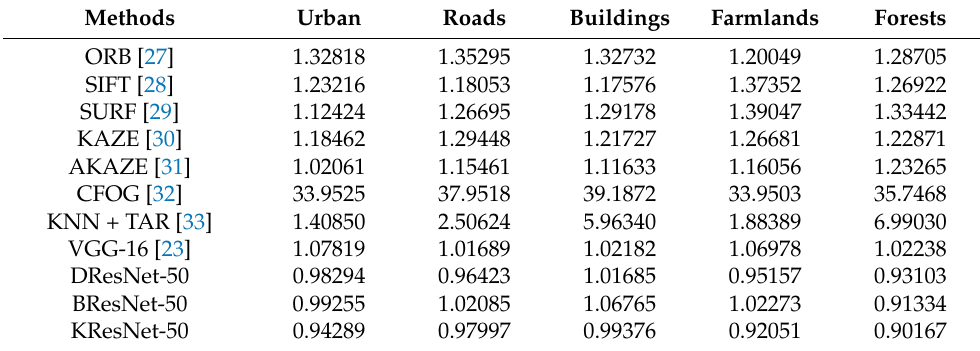
Table 1. Accuracy comparison of different registration algorithms